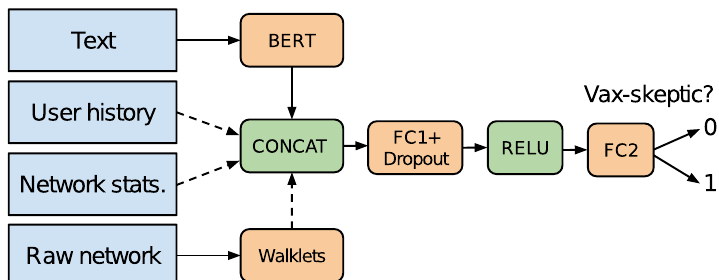
Fig. 10 Schematic view of the pro- versus anti-vaxxer classifier framework. Tweet text and network representations are obtained by BERT and Walklets, respectively. User history, network statistics and raw network vectors can be independently turned on and off. The downstream classifier consists of two fully connected (FC1, FC2)